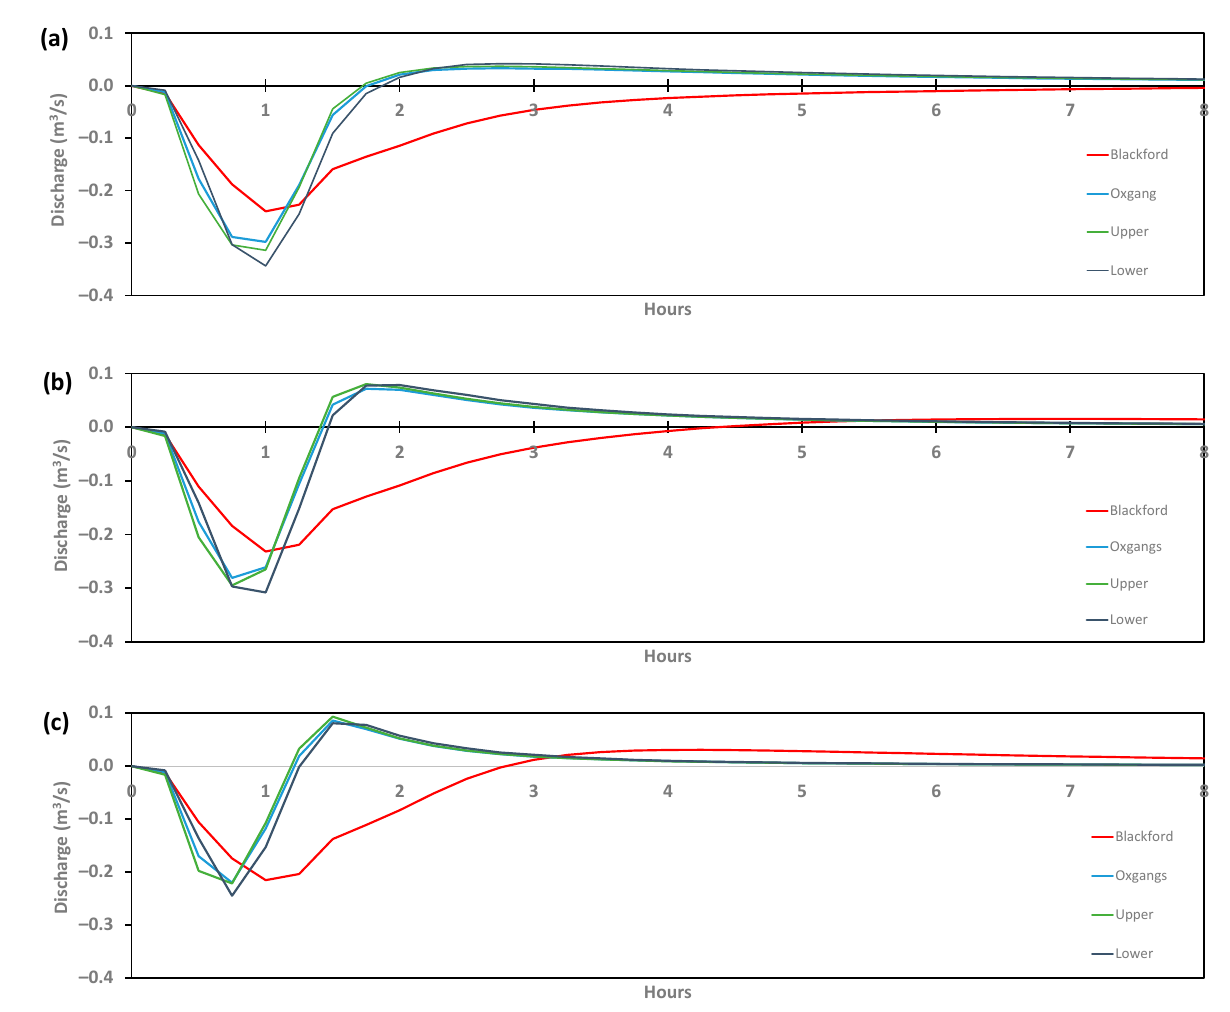
Figure 5. Difference in flow into the adjacent water courses for a 1 in 100 year 1 h event starting at hour 0. These are the differences between the baseline run and the incorporated pond. ( a ) increased storage, ( b ) standard storage, ( c ) decreased storage.